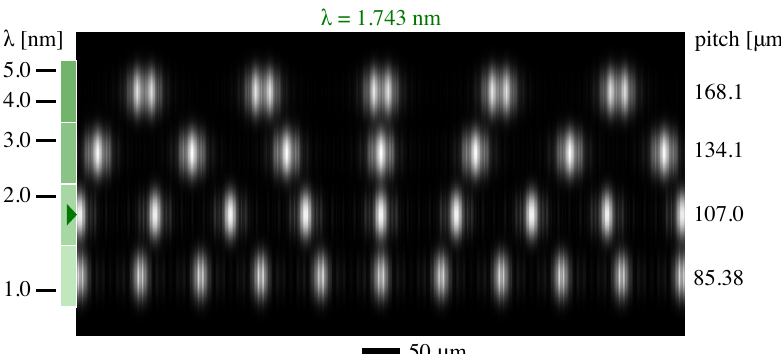
Figure 9. Hartmann detector-plane intensity pattern detail, calculated for the wavelength corre- sponding to the design of the second-lowest row (green marker). The beamlets in that row have a smooth intensity profile and minimal overlap. Green colored rectangles align to the scale at the left and show wavelength ranges over which each grid is designed to be used. We observe that the two grids designed for larger wavelengths project spots with a more prominent structure, while grids designed for smaller wavelengths show adjacent beamlet interference.